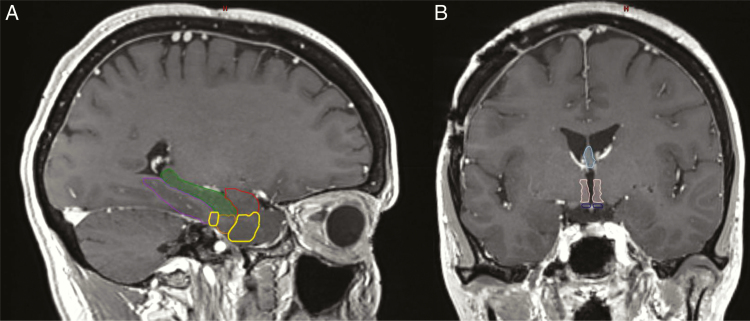
(A) Sagittal MRI demonstrating the anatomy of the medial temporal lobe structures: the amygdala (red), hippocampus (green), parahippocampal cortex (purple), perirhinal cortex (yellow), and the entorhinal cortex (orange). (B) Coronal MRI demonstrating the fornix (light blue), hypothalamus (light pink), and mammary bodies (dark blue).